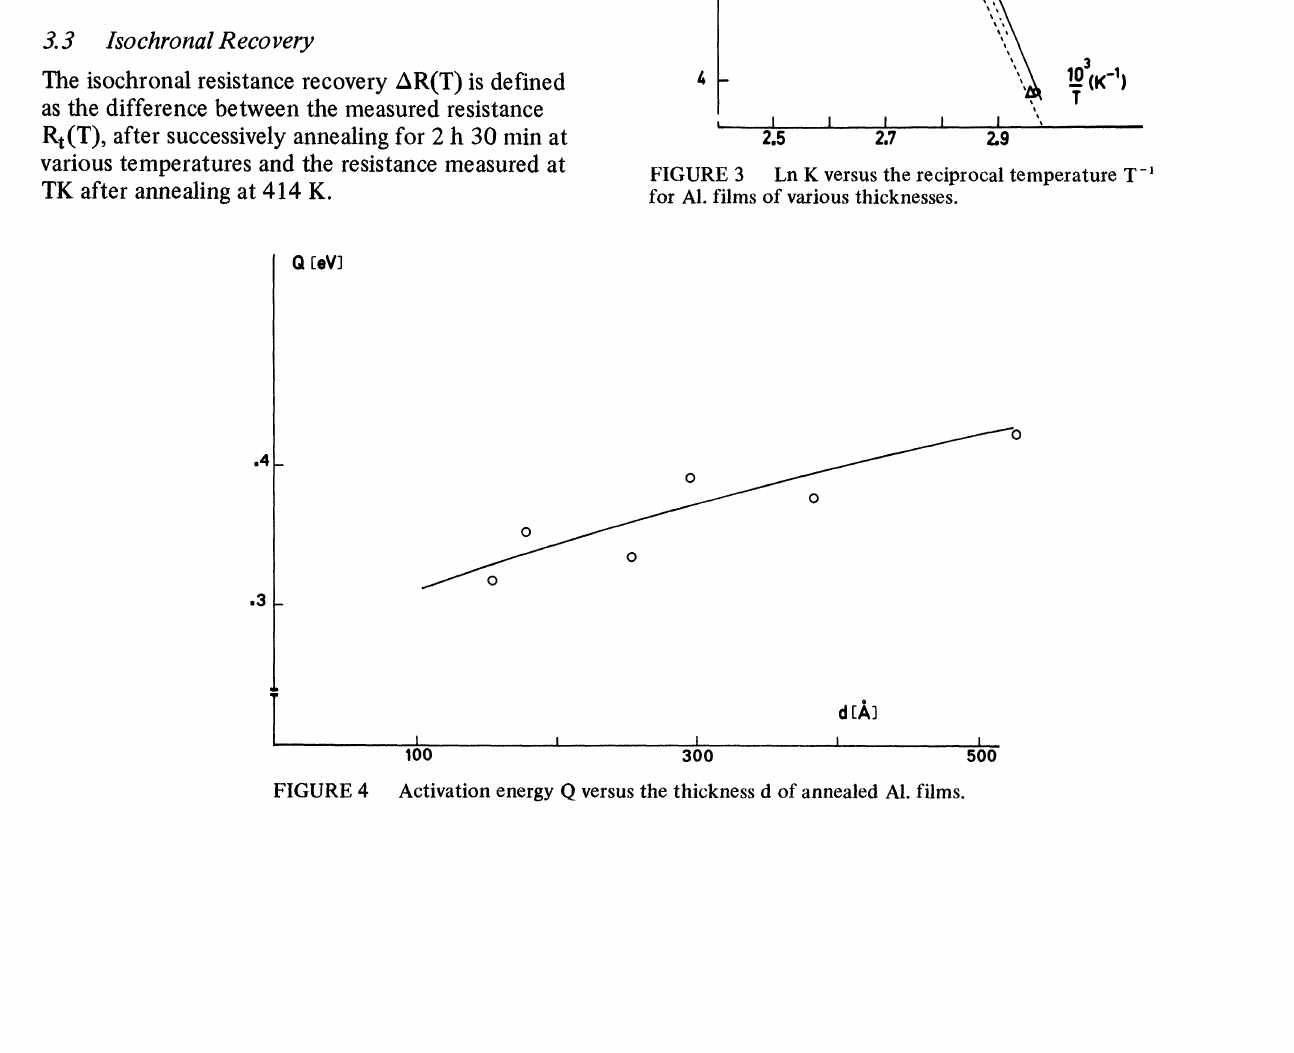
Ln K versus the reciprocal temperature T for A1. films of various thicknesses.